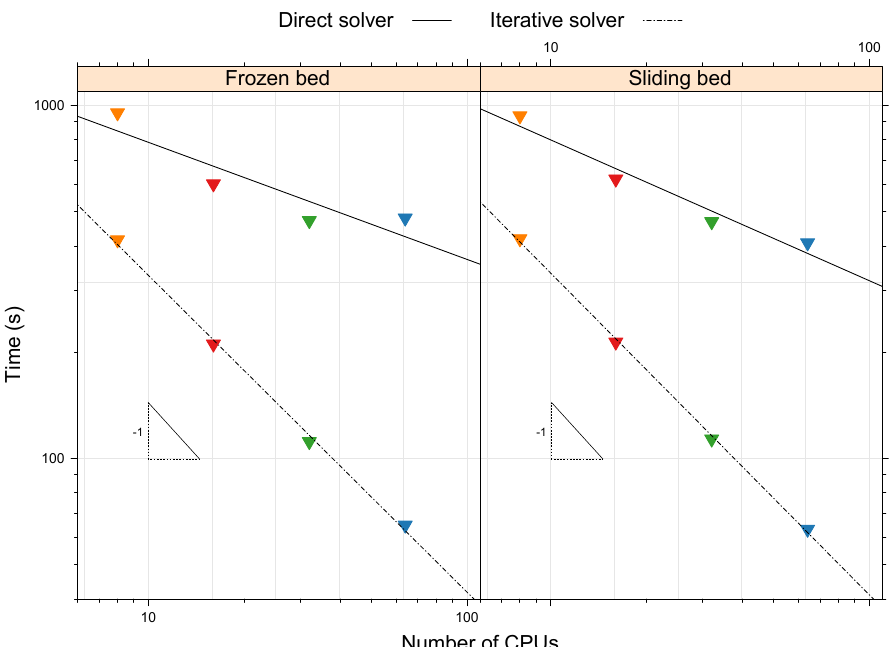
Figure 6. Strong scalability of the default ISSM solver (MUMPS) compared with a combination of robust solvers (selected from the high- lighted solvers in Figs. 2–4) for the components of the transient ISSM simulation of ISMIP-HOM Experiment F. See Fig. 5 for the solvers specified for each analysis component. Strong scalability represents the impact of increasing the number of CPUs while keeping the mesh size constant (16000 elements). Ideal strong scalability is consistent with a slope equal to − 1. Timing results include the CPU time associated with assembling the stiffness matrix and load vector, solving the system of equations, and updating the input from the